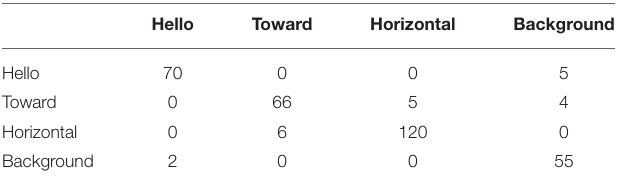
TABLE 1 | The confusion matrix for on-chip classification of the radar gesture dataset